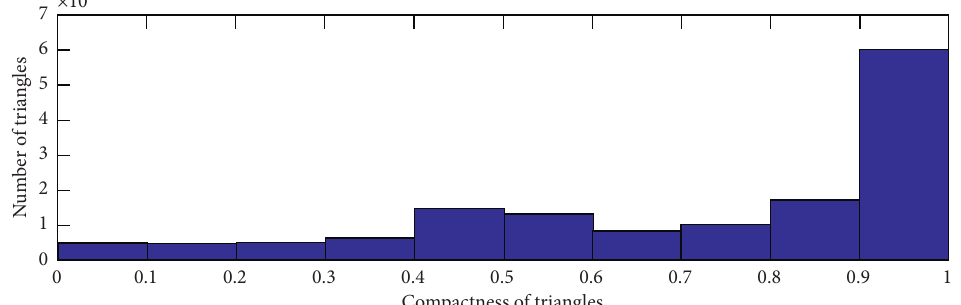
Figure 4: The compactness of the simplified surface of Bimba point set.